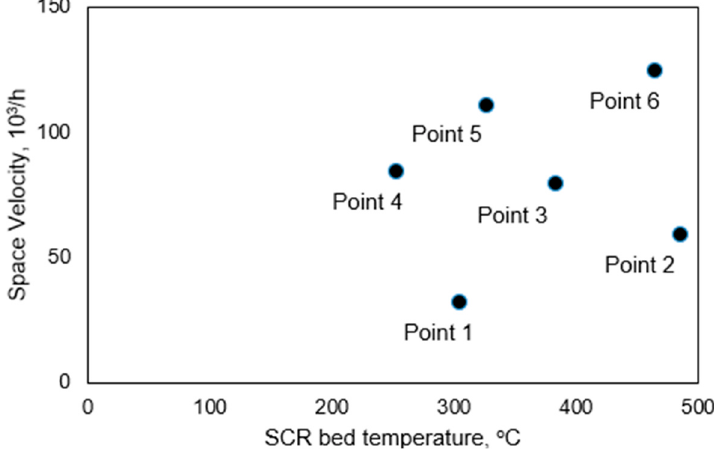
Figure 16. Typical boundary conditions.